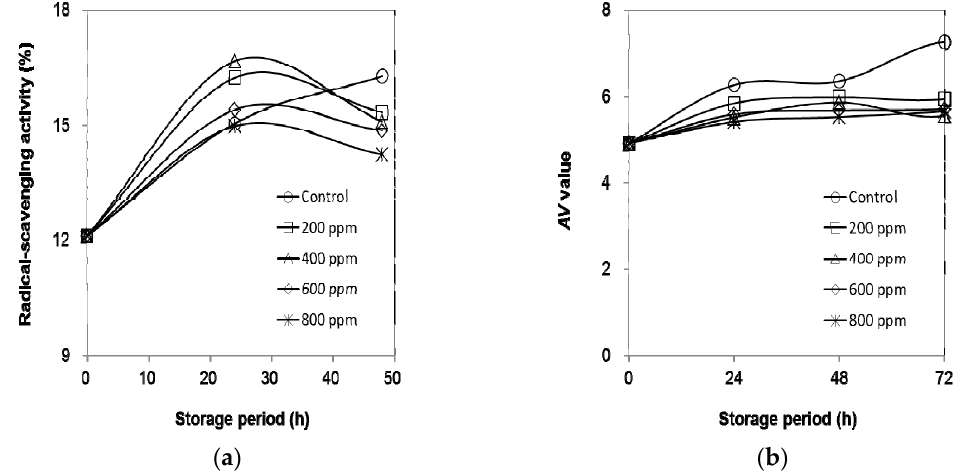
Figure 4. ( a ) DPPH radical scavenging activity and ( b ) AV values of olive oil supplemented with different amounts of the extract.